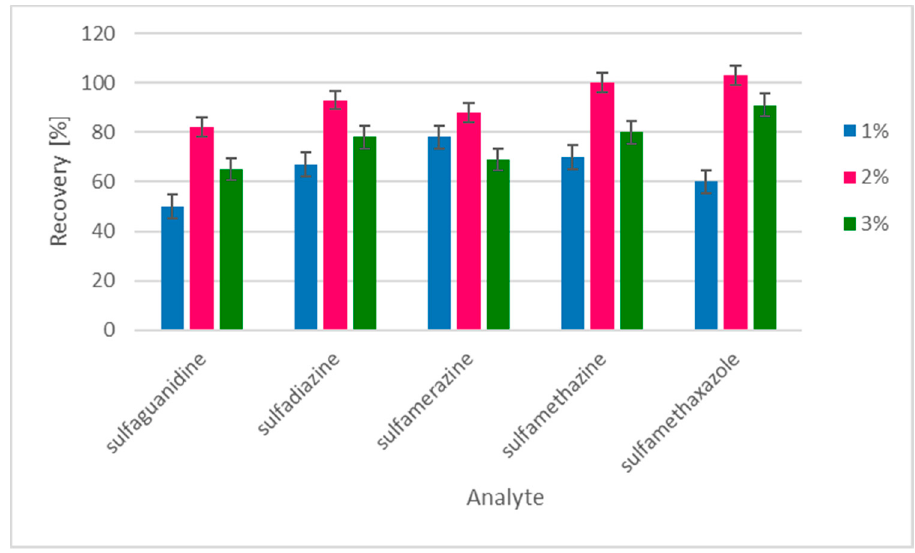
Figure 2. The recoveries of 5 sulfonamides with three SPE eluting conditions ( n = 6).